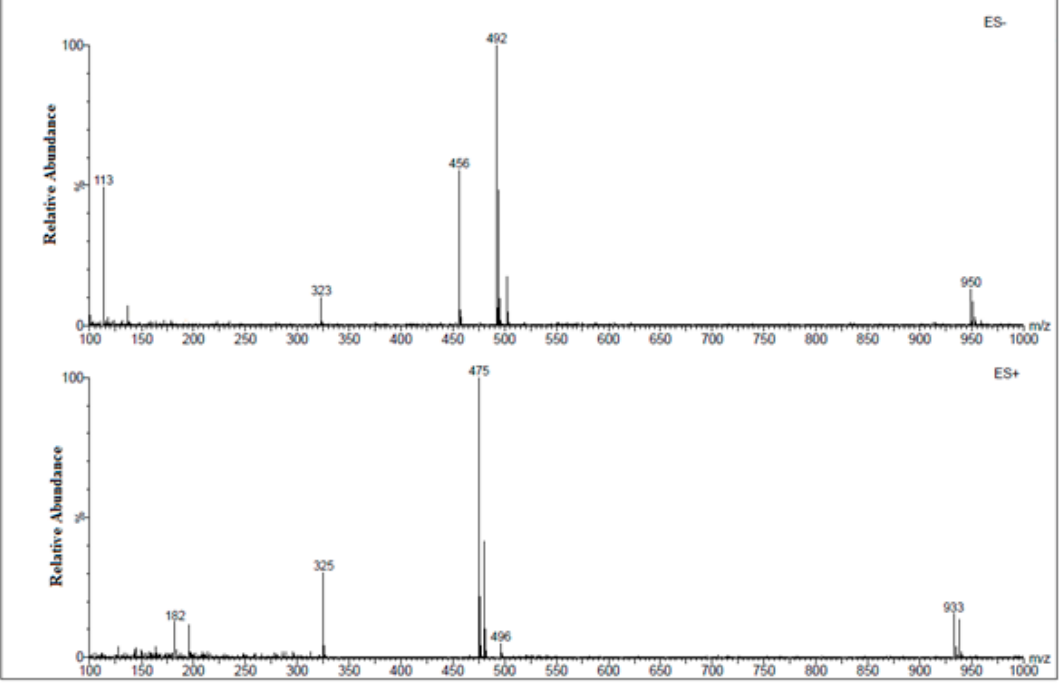
Figure 11. UV spectrum of amygdalin, HPLC retention time t R = 6.33 min.